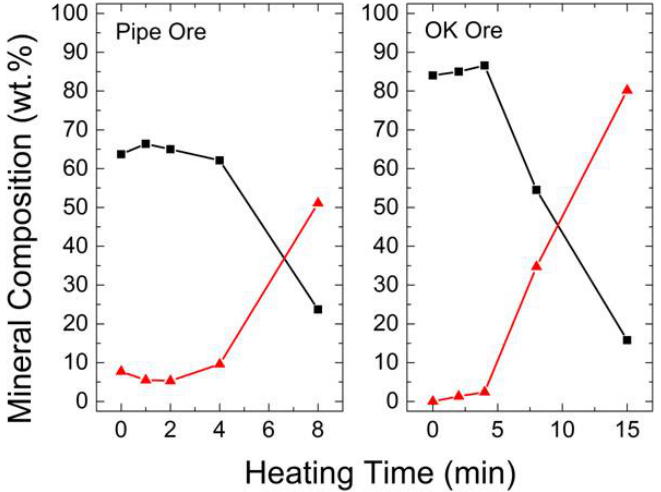
Figure 5. Serpentine ( (cid:4) ) and olivine ( (cid:78) ) content of Pipe and OK ores as a function of microwave heating time.